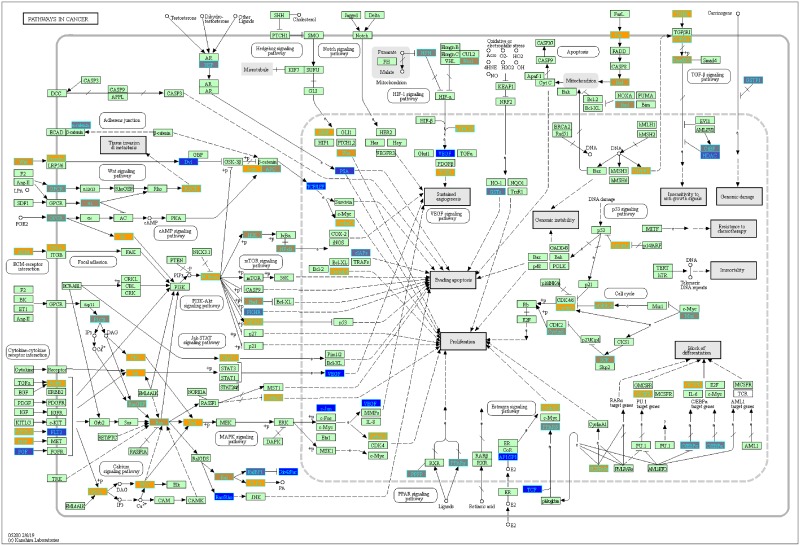
Highlighted pathways in cancer (hsa5200) with enriched genes from the LRT (q-value < 0.05) [49–51].Yellow-colored genes are up-regulated and blue-colored genes are down-regulated in COPD samples.